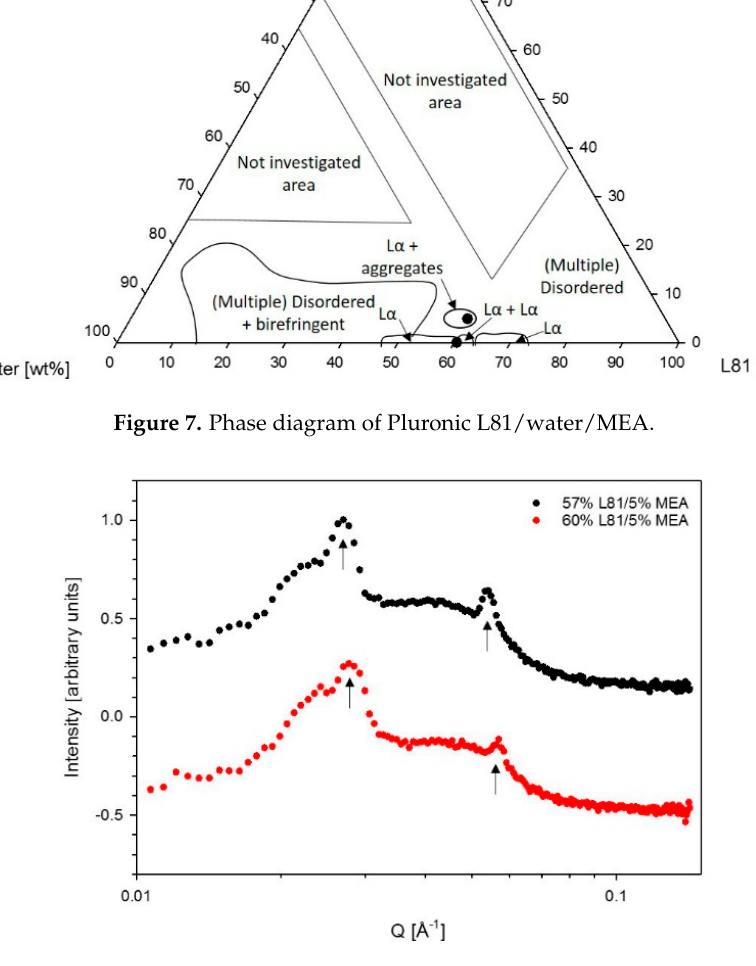
Figure 8. SAXS spectra of 57% L81/5% MEA and 60% L81/5% MEA. The arrows indicate the peaks following lamellar ratios of 1:2. Table 1. Lattice parameters of L81/water mixtures.